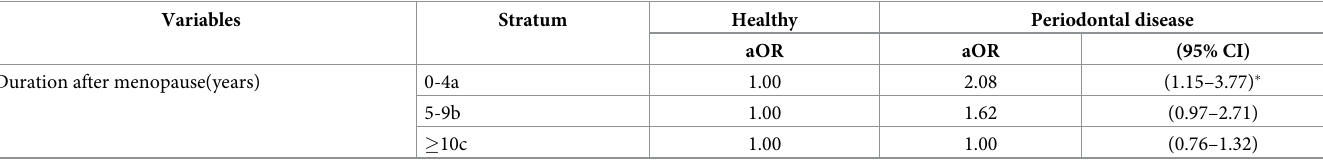
Table 3. Association between osteoporosis and periodontal disease according to duration after menopause (years).